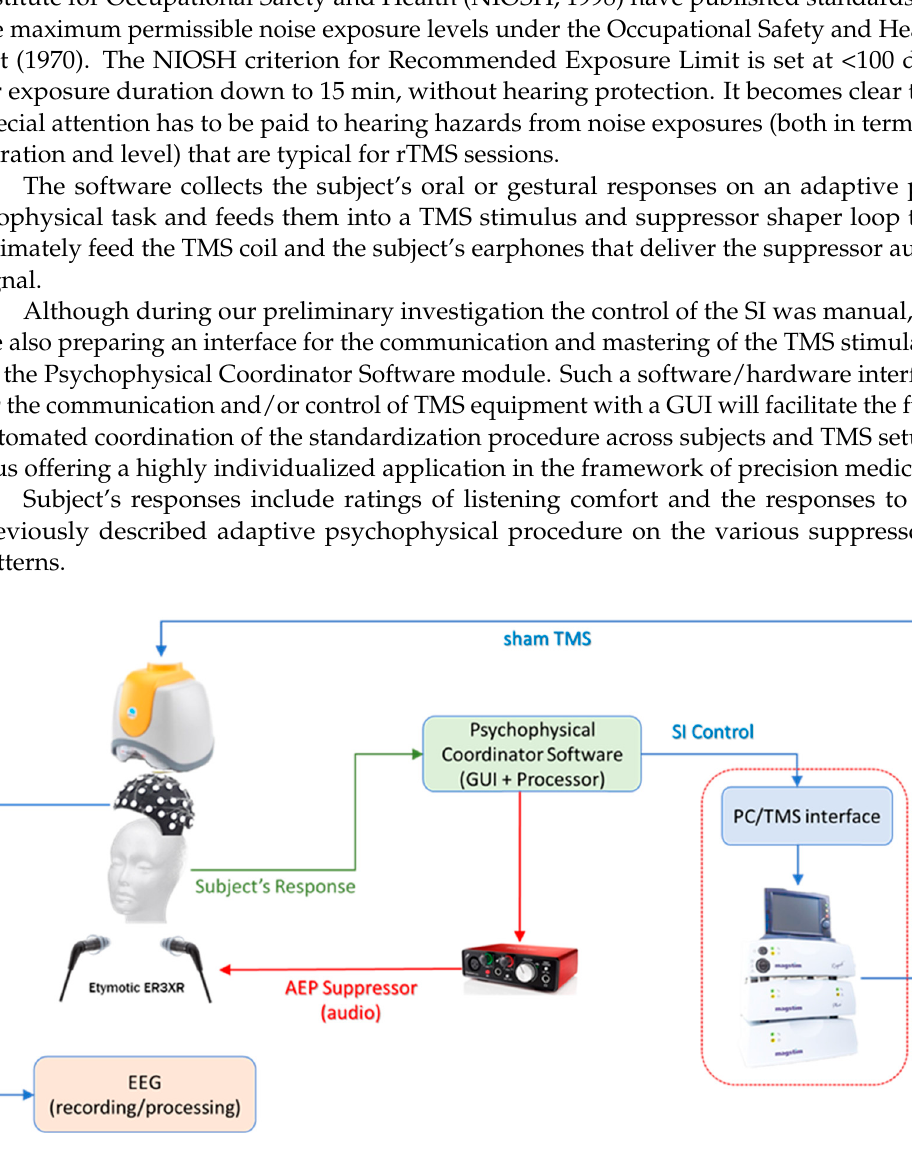
Figure 4. Procedure for the fine-tuning of the suppressor’s parameters.